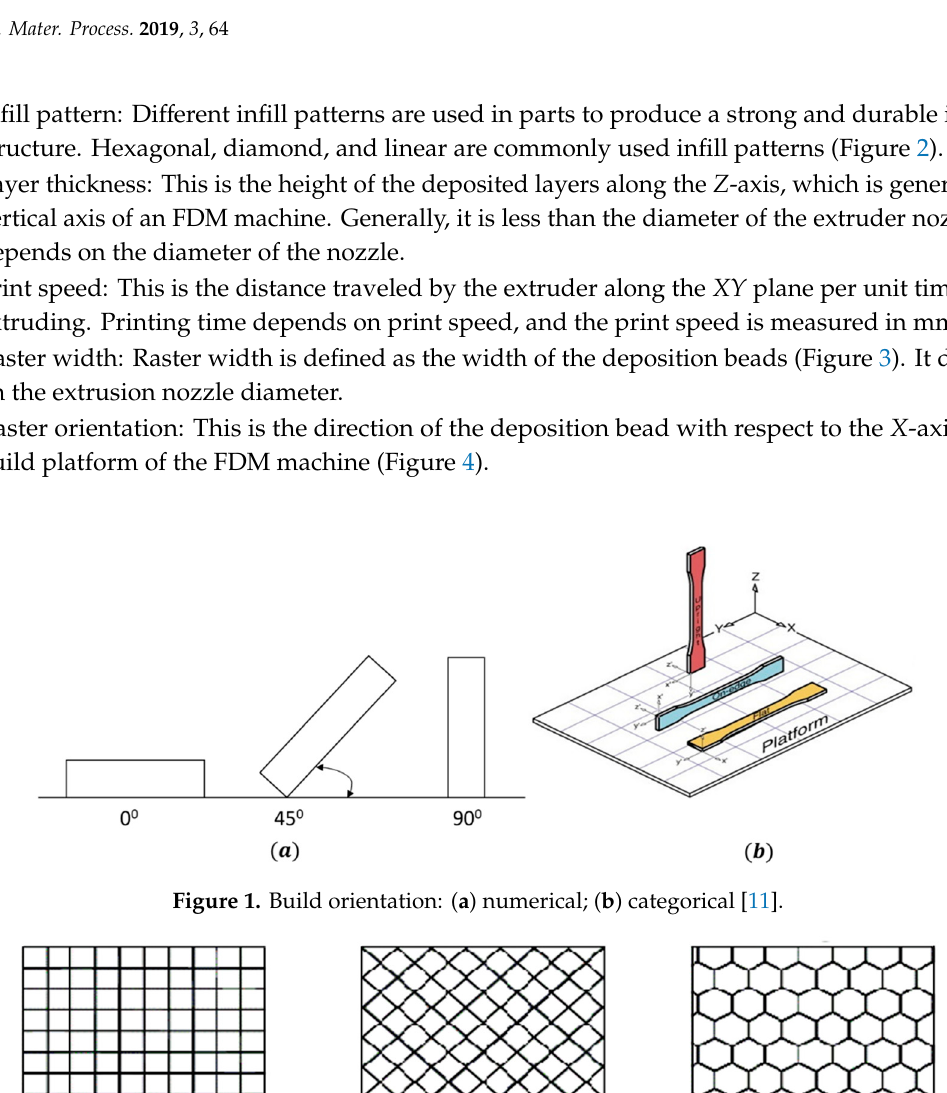
Figure 2. Infill pattern: ( a ) linear; ( b ) diamond; ( c ) hexagonal [20].